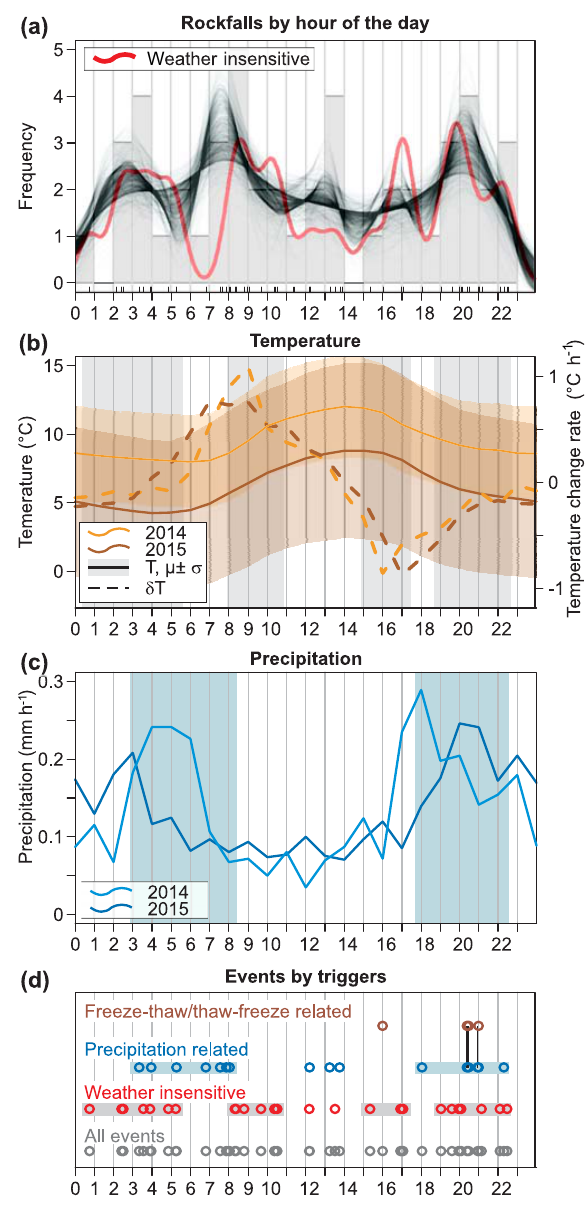
Figure 8. Rockfall activity and potential drivers and triggers grouped by the hour of the day. (a) Histogram with 1h wide bins is overlaid with Monte-Carlo-based kernel density estimates (grey lines, kernel size changed between 0.5 and 2h) and a deterministic KDE (kernel size 0.8h) of the weather-insensitive events. (b) Daily air temperatures (solid lines and polygons) and temperature change rates (dashed lines) for summer–autumn 2014 and spring 2015. (c) Average precipitation for the two instrumented periods. (d) Indi- vidual events grouped by drivers. “Freeze–thaw related” is defined as time lags < 4h (cf. density drop after that time in Fig. 7d). “Pre- cipitation related” is defined as time lags < 4h. (cf. density drop after that time in Fig. 7b). “Weather insensitive” is defined as being neither freeze–thaw nor precipitation